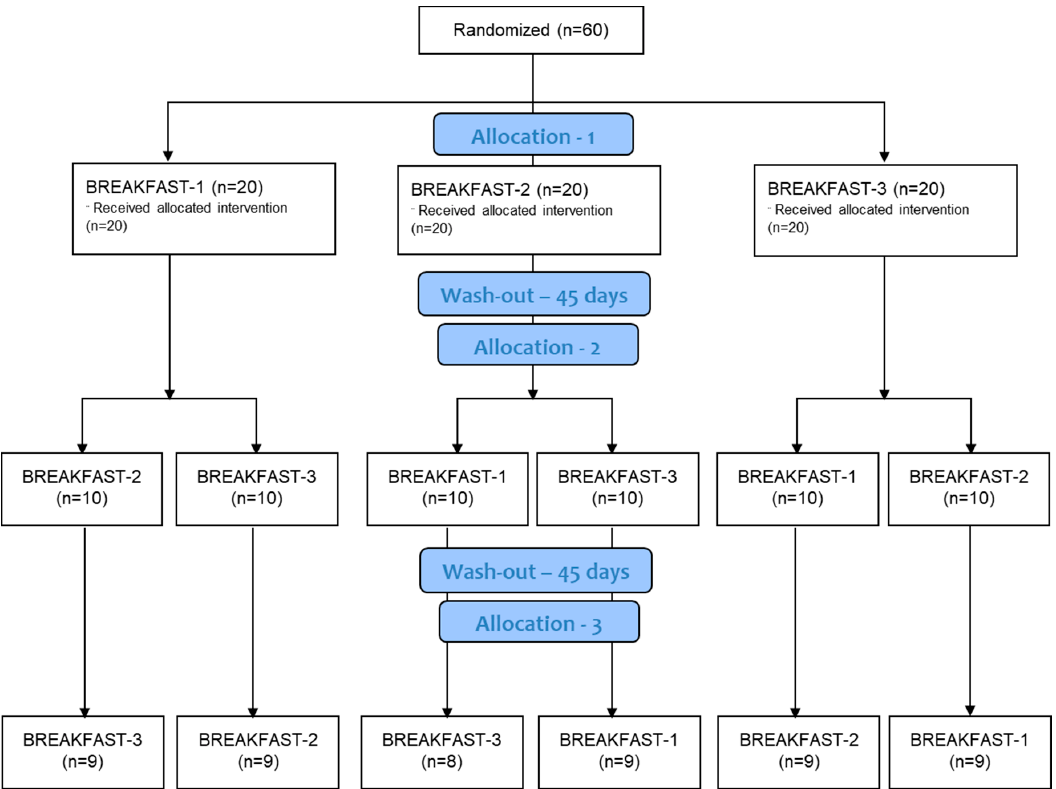
Figure 2. Participants’ flow diagram of the present study.